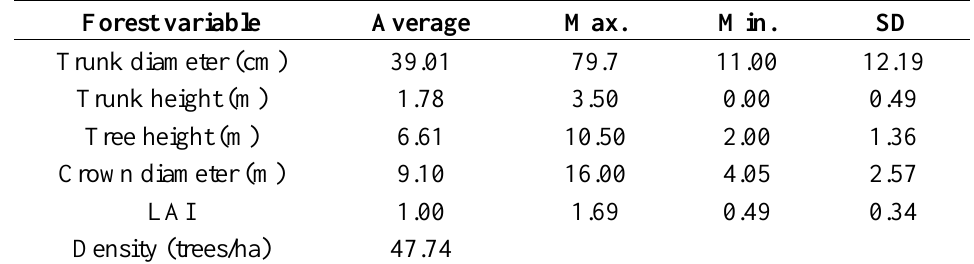
Table 1. Tree statistics of the samples measured (average, maximum, minimum values and standard deviation